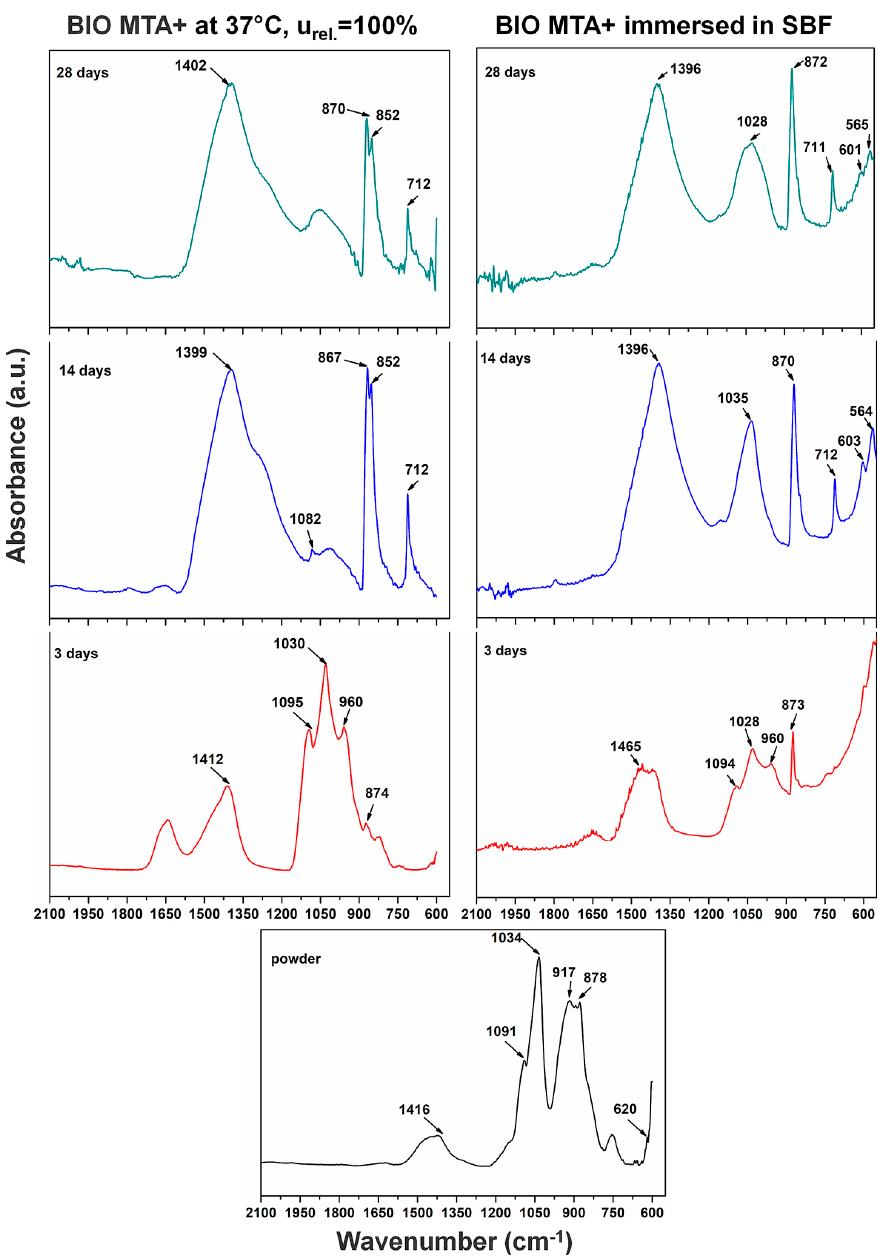
Figure 11. FT-IR spectra for BIO MTA + during the setting reaction and immersion in Figure 11 . FT-IR spectra for BIO MTA+ during the setting reaction and immersion in SBF . The initial TheraCal spectrum showed a CO 32 − band at 700 cm − 1 and a band at 917 cm − 1 assigned to SiO 44 − stretching for the alite crystal phase. A characteristic bending for alite (Ca 3 SiO 5 ) could be seen at 937 cm − 1 . Bands of PO 43 − groups were visible at 1043 and 1075 cm − 1 and a band for asymmetric